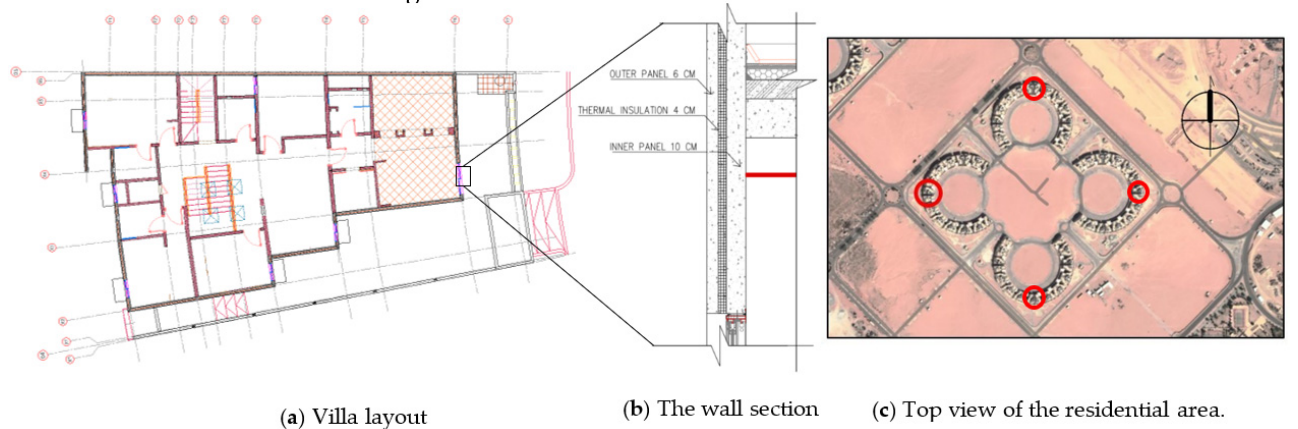
Figure 2. Location of an experimental study in Qassim University, ( a ) Villa layout, ( b ) The wall section, ( c ) Top view of the residential area.